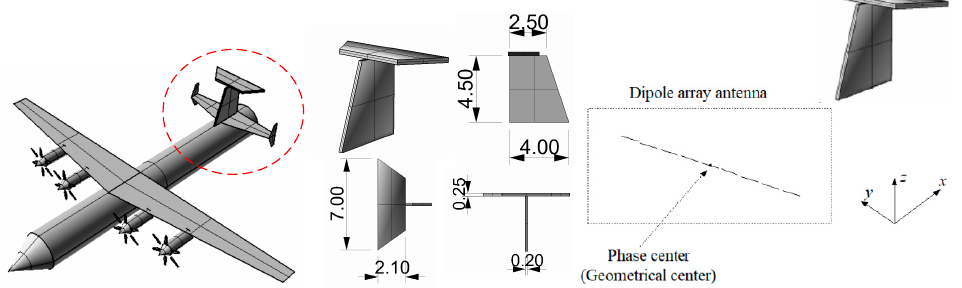
( b ) Figure 7. ( a ) Disturbed pattern on xoz plane; ( b ) disturbed pattern on yoz plane. The requirements for computing resources of MoM are taken into account in this example; a parallel strategy is set and used on a high performance platform. It is neces- sary to point out that to obtain the disturbed pattern, the presented method does not need any high-performance resources beyond a common personal computer with 8 GB RAM. The cost of computing is listed and compared in Table 1, in which the efficiency of the proposed method can be seen. Table 1. Comparison of computing cost. CPU Used